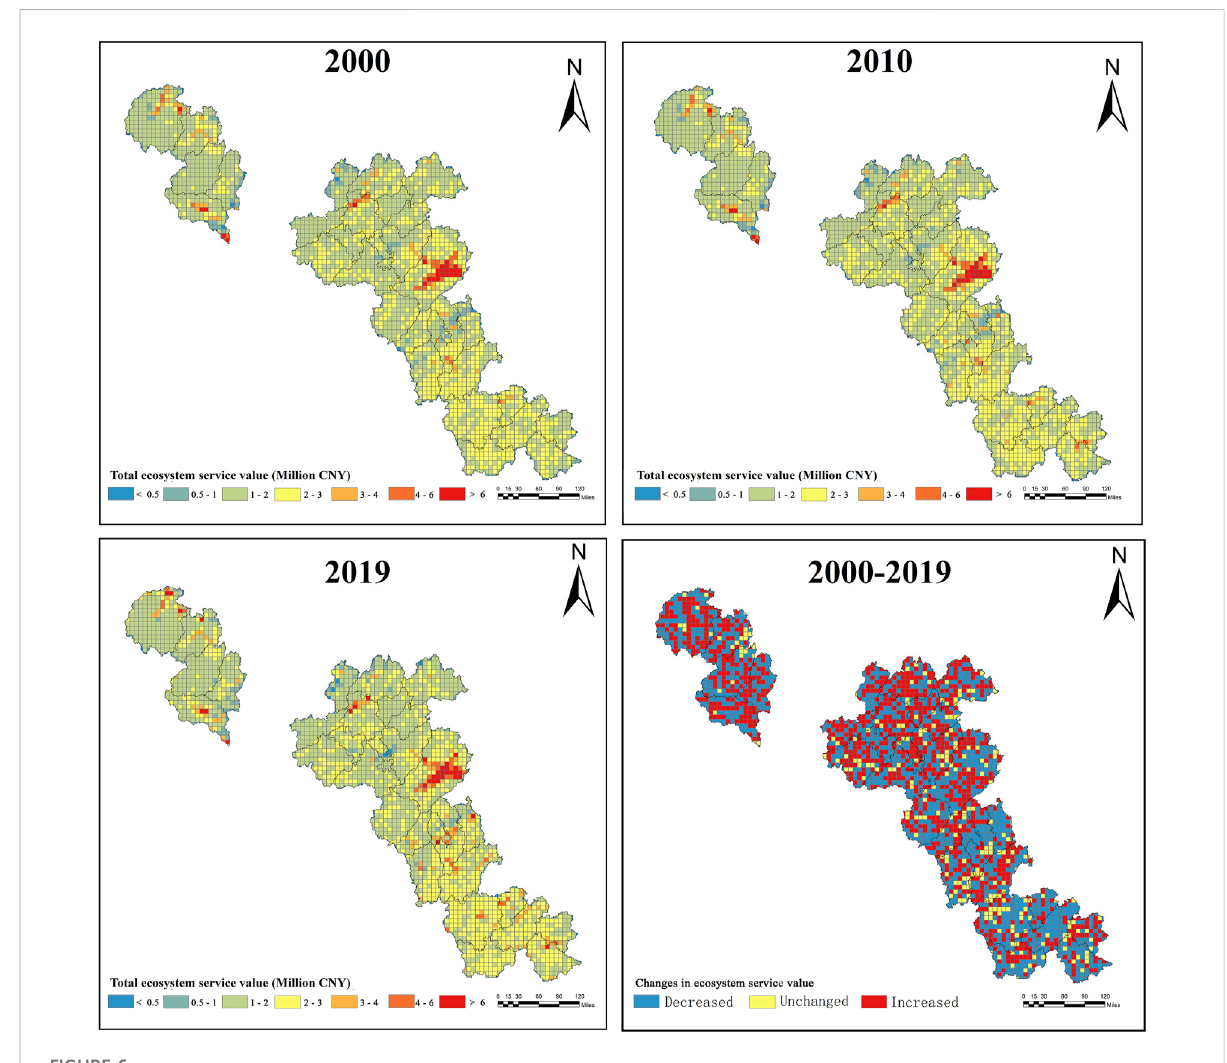
FIGURE 6 Spatial distribution of ESV in the YRDEB from 2000 to